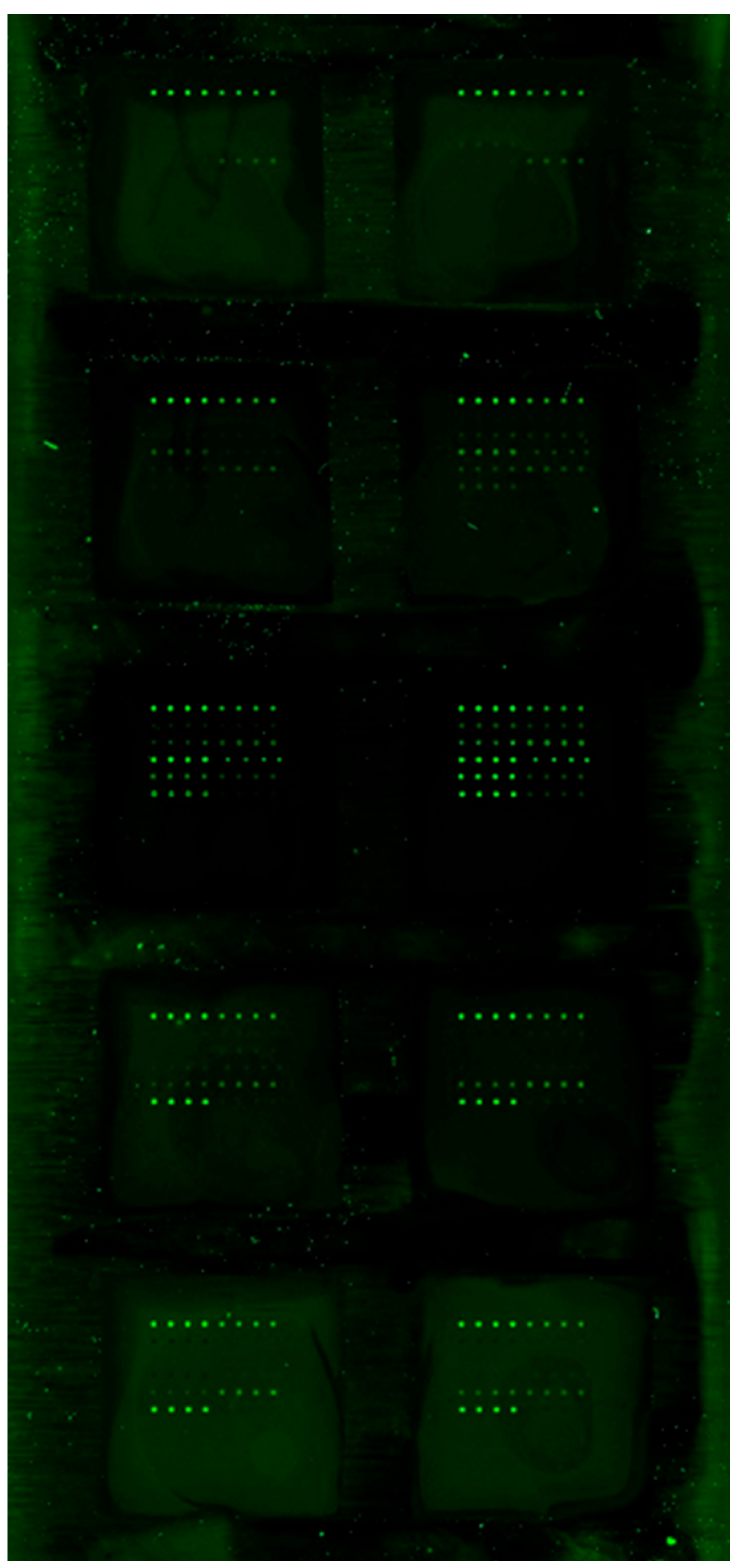
Figure 3. Representative Quantibody ® multiplex ELISA array slide analyzed by RayBiotech, Inc. to provide quantitative concentrations of the ten cytokines/chemokines for each of the 34 postural orthostatic tachycardia syndrome (POTS) patients evaluated in this study.